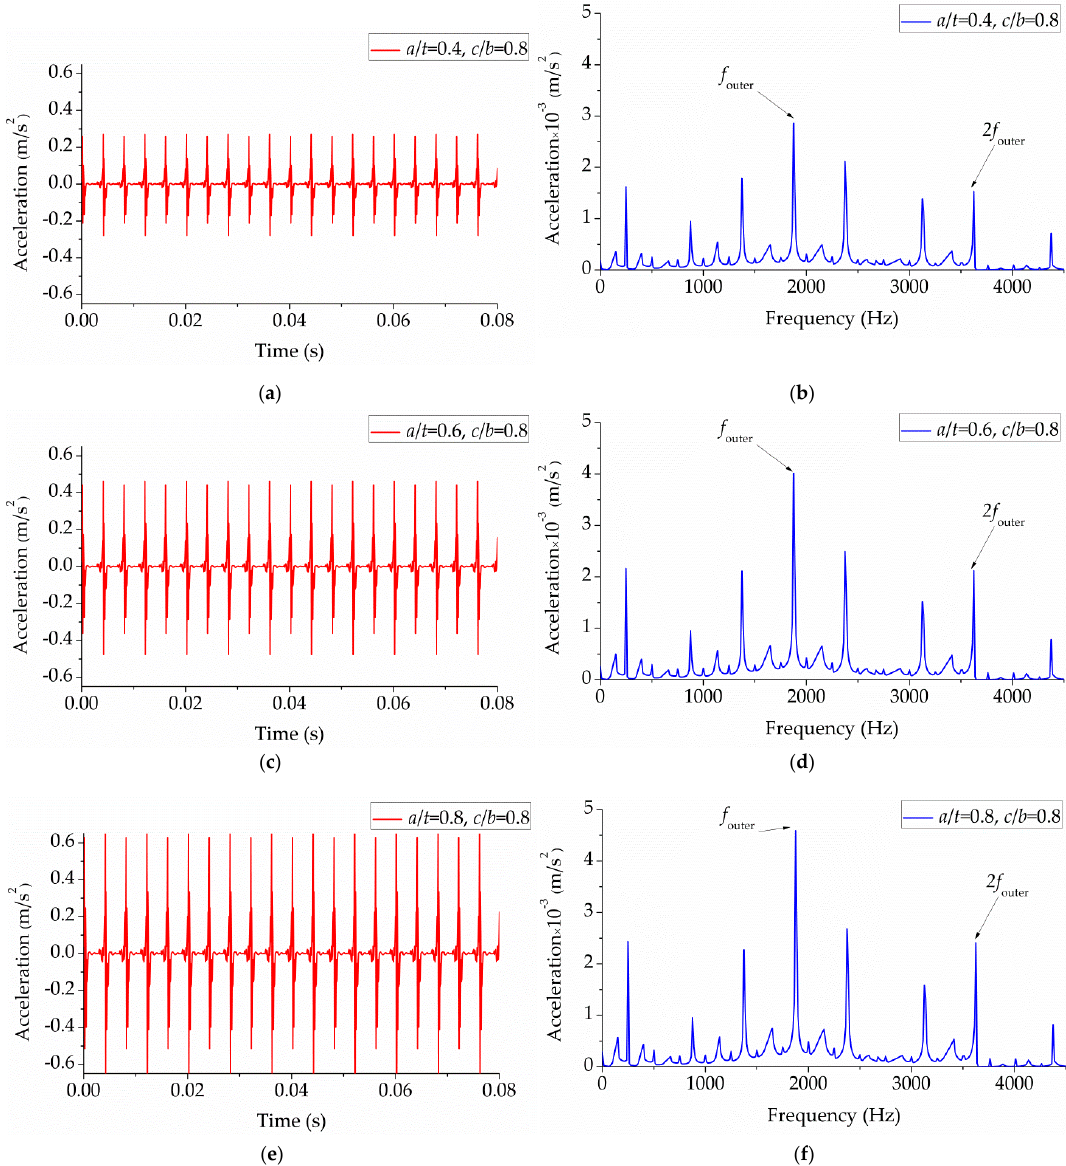
Figure 13. c / b = 0.8 time domain and frequency domain curves of vibration signals corresponding to different a / t : ( a , b ) Time-domain and frequency-domain response signals in case a / t = 0.4 c / b = 0.8; ( c , d ) time-domain and frequency-domain response signals in case a / t = 0.6 c / b = 0.8; ( e , f ) time-domain and frequency-domain response signals in case a / t = 0.8 c / b =0.8.